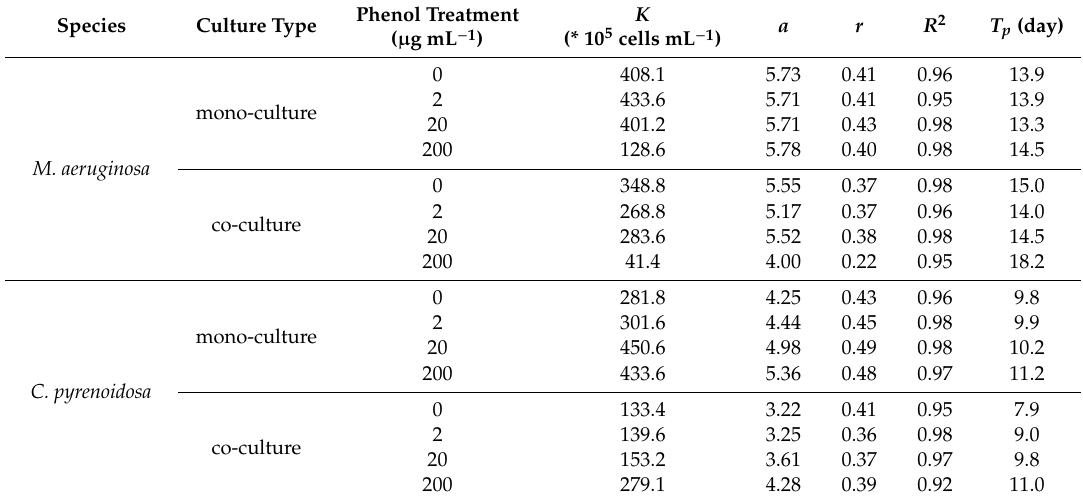
Table 3. Logistic equation parameters for two species in mono- and co-cultures.